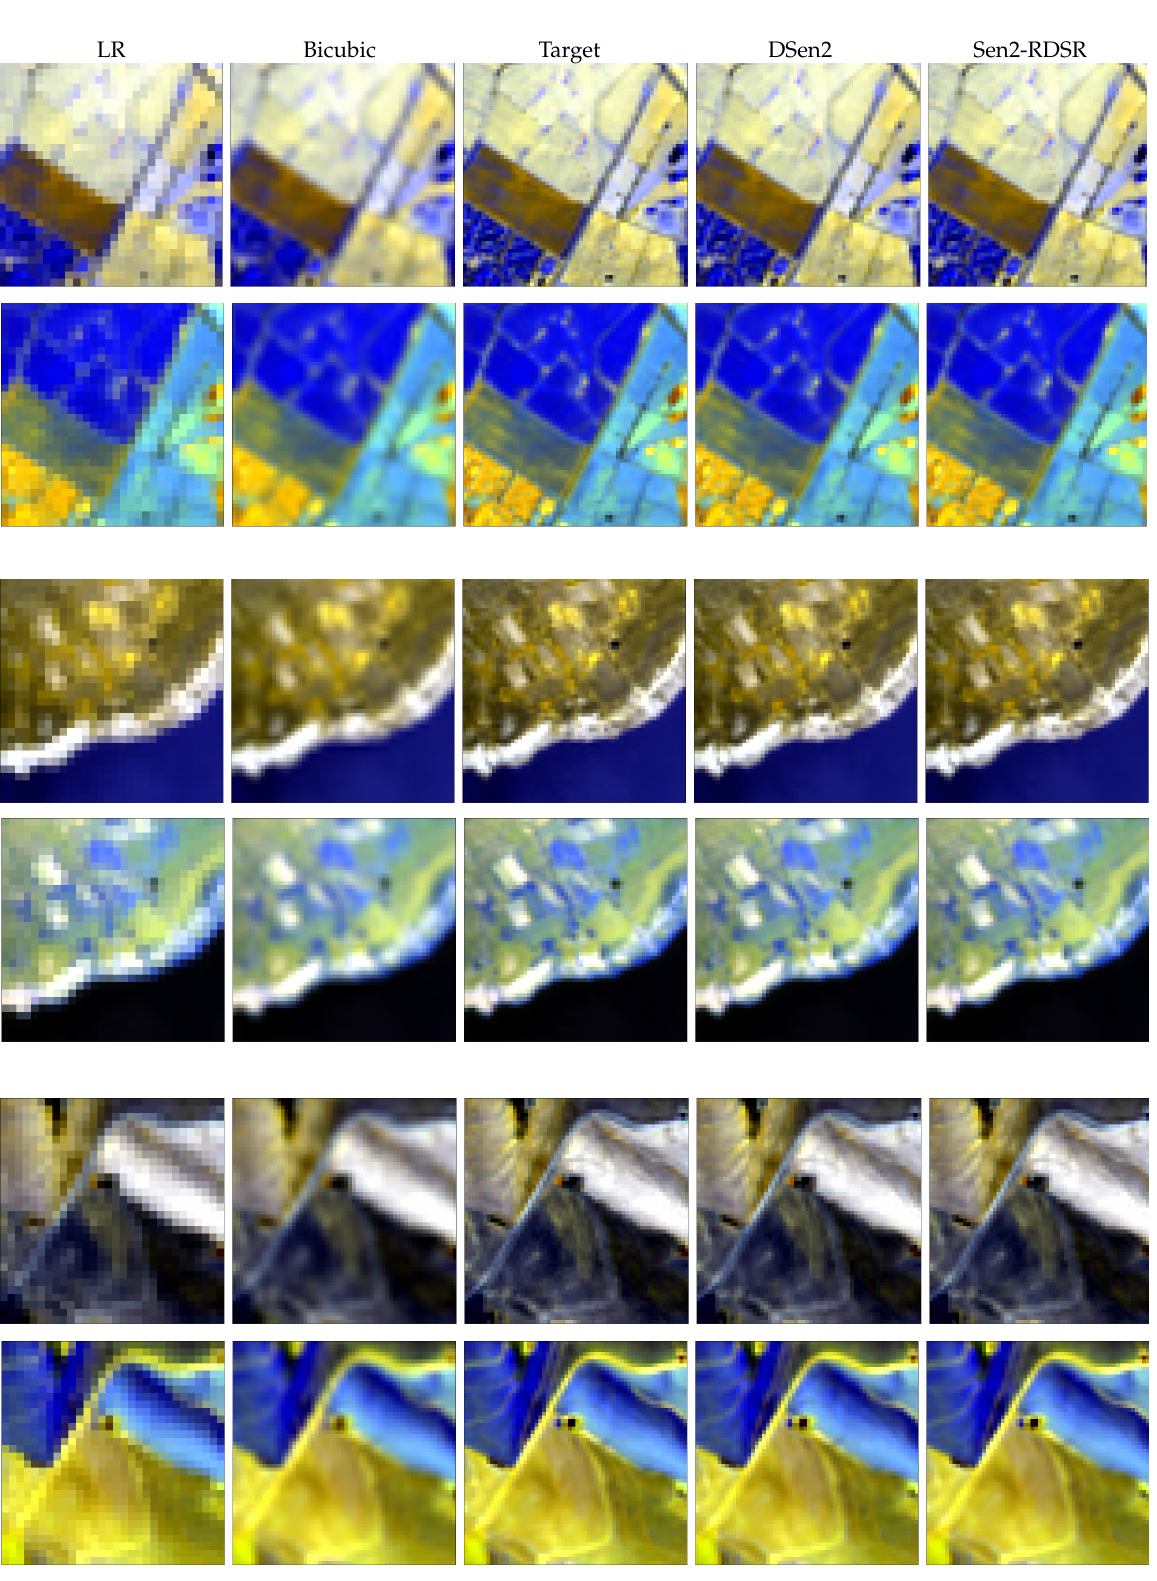
Figure 4. Sharpening results for Sentinel-2 20 m bands. Images correspond to different crops from the test set. Odd rows show the false-color composite {B7,B6,B5} as RGB and even rows show the false-color composite {B12,B11,B8A}. The first column corresponds to the original LR 20 m bands, the second column is the bicubic interpolation, the third column is the target image, the fourth column is the result from DSen2 [4], and the fifth column is our result. The size of the images is 30 × 30 pixels for LR and 60 × 60 for the